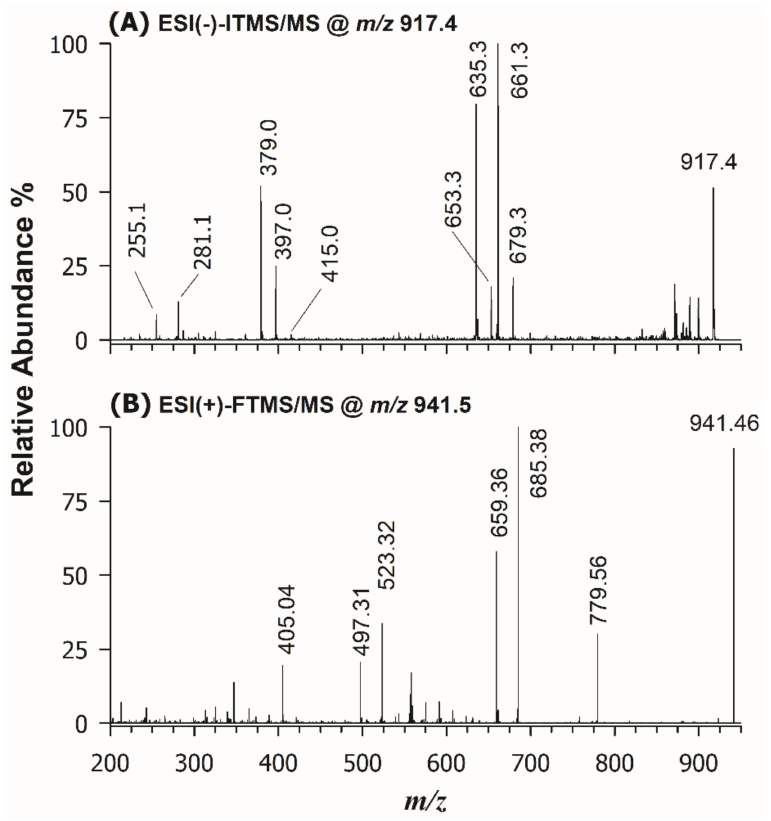
Figure 4. ( A ) ESI(-)-ITMS/MS spectrum, obtained after HILIC separation of the BD extract of U. pinnatifida , of the [M-H] – ion detected at m/z 917.4; ( B ) ESI(+)-FTMS/MS spectrum, obtained upon direct infusion of the same BD extract after sodium acetate addition, for the [M+Na] + ion detected at m/z 941.46. The final assignment inferred from the two spectra was DGDG